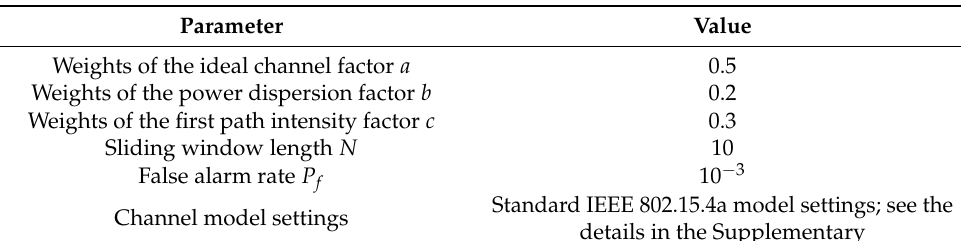
Table 2. Simulation settings.